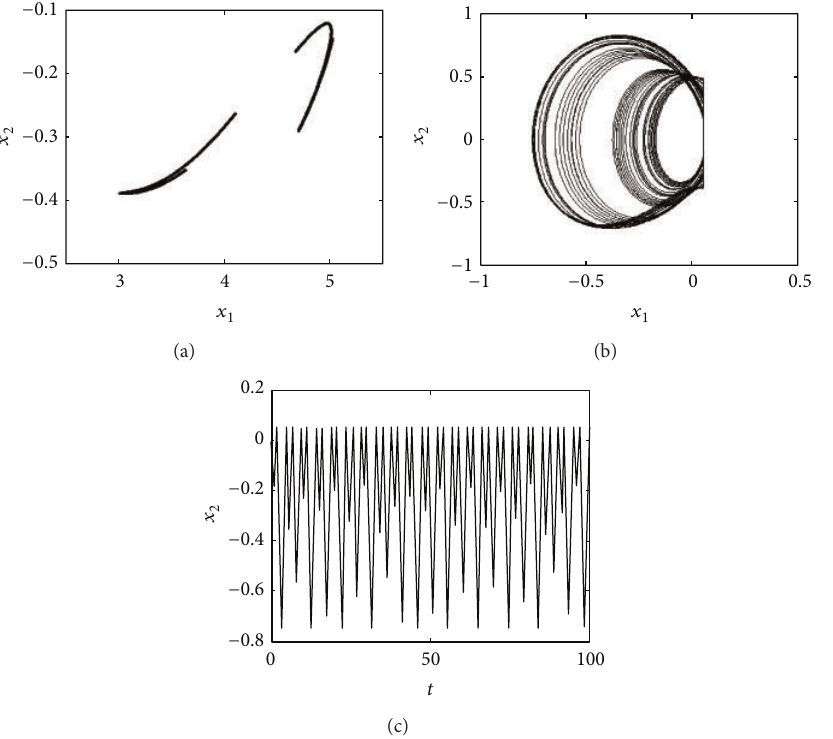
Figure 8: Poincar´e map, phase portrait, and time course diagram of the system with 𝜔 = 2.52 .